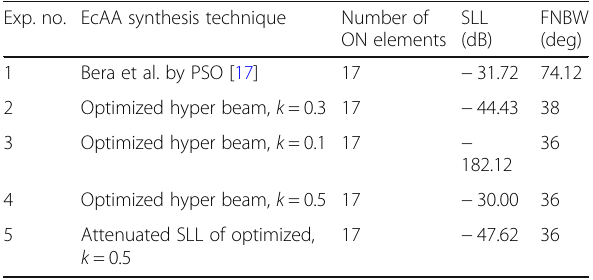
Table 1 Comparison of SLL and beam width Exp. no. EcAA synthesis